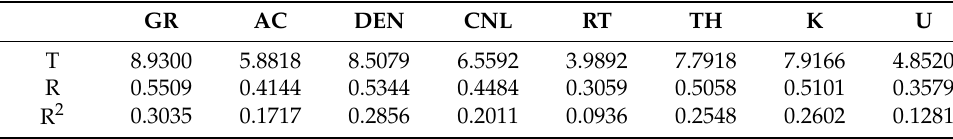
Table 1. Correlation analysis and significance test of each logging